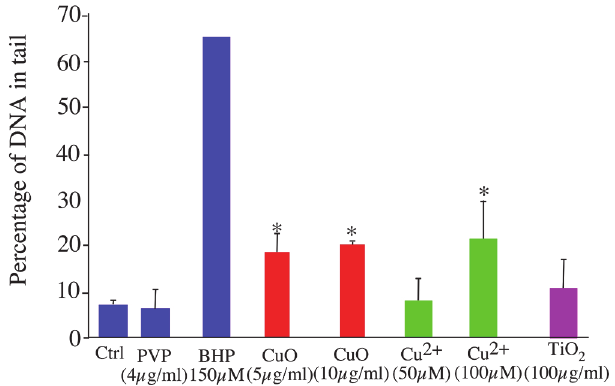
Fig 2. Assessment of DNA damage. Damages to DNA on J774 cells after treatment with copper oxide nanoparticles, copper ion and titanium dioxide nanoparticles were evaluated using the alkaline version of the comet assay, taking into account both single and double strand breaks. The results are expressed in percentage of DNA in the tail. Butylhydroperoxide (BHP) was used as a positive control. Measurements were carried out in triplicate (except for BHP where n = 1). Statistical confidence (Student T-test) is indicated as follows: * : p (cid:1) 0.05; ** p (cid:1) 0.01; *** p (cid:1)